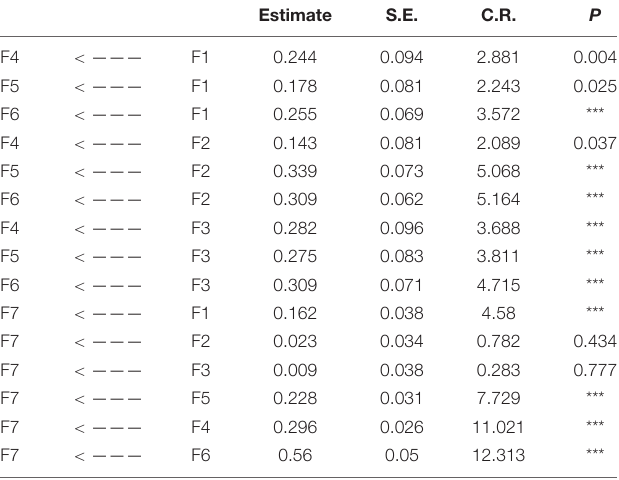
TABLE 3 | Results estimated by AMOS.